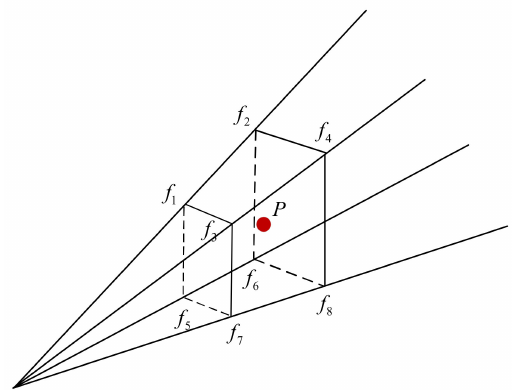
Figure 3. Schematic of the eight-point interpolation